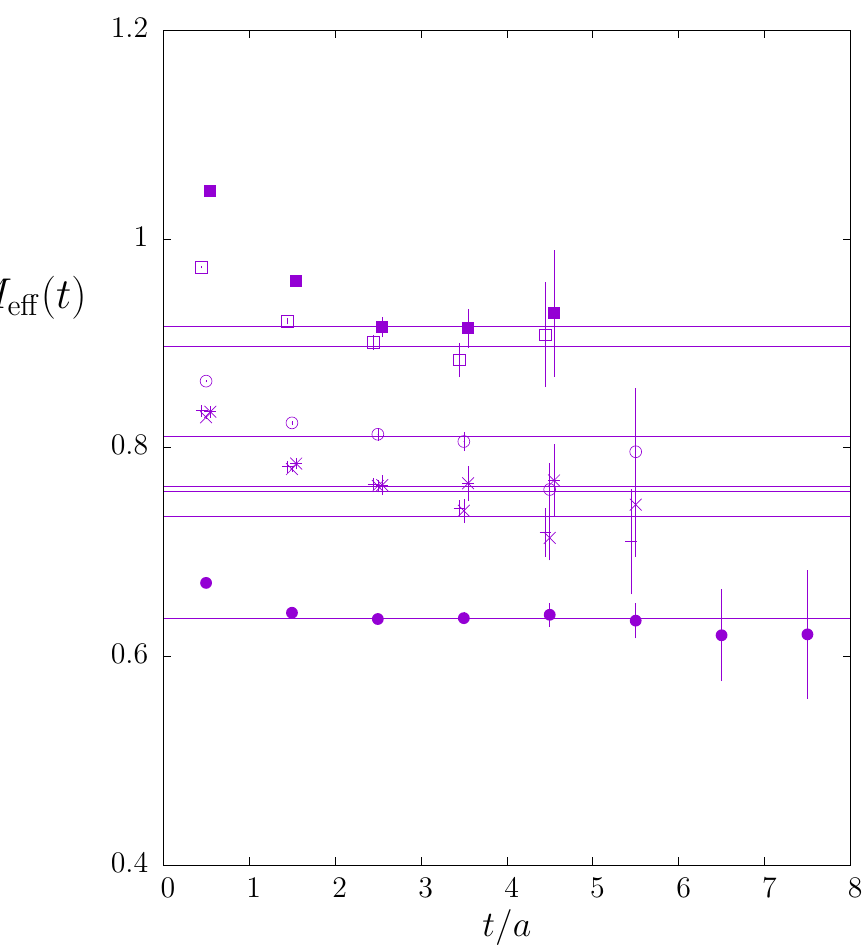
Figure 9 . Effective masses for the ground ( • ) and for the first excited ( ◦ ) J PC = 1 + − states. Also the J PC = 2 + − ground state: 2 of the 5 components from the ground state E ( (cid:4) ) and the other 3 from the first excited T 2 state ( (cid:3) ). And the J PC = 3 + − ground state: one component from the A 2 ground state ( ? ), three from the T 2 ground state ( + ), and three from the first excited T 1 state ( × ). Some points shifted for clarity. Horizontal lines are our best mass estimates. On the 38 4 lattice at β = 6 . 50